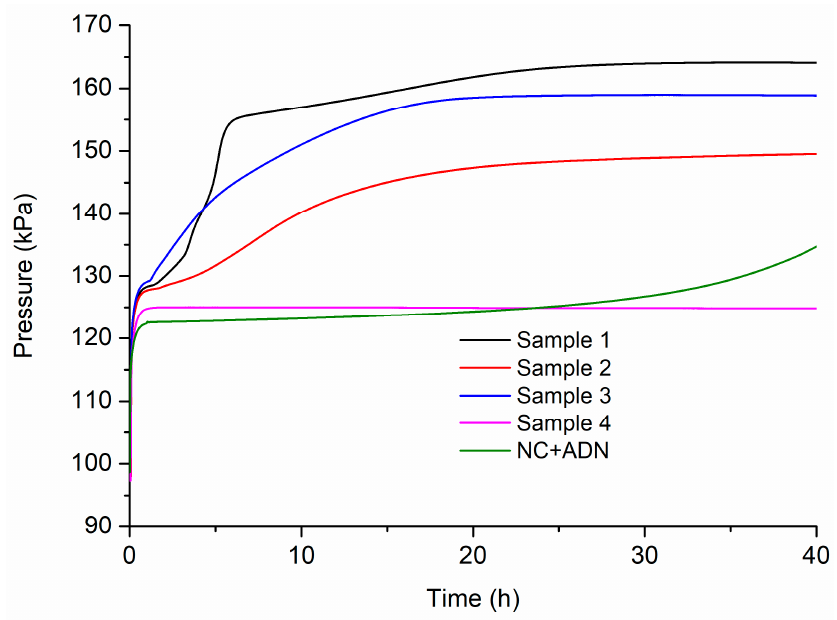
Figure 6. Pressure curves of NC-based composite fibers at 100 °C.